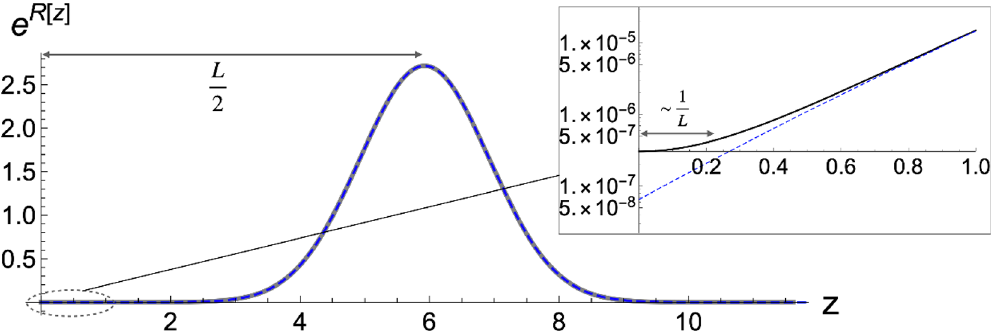
Figure 2 . A mass profile of the non-uniform black string with R (0) = − 15 . The Gaussian solution is plotted by the blue dashed